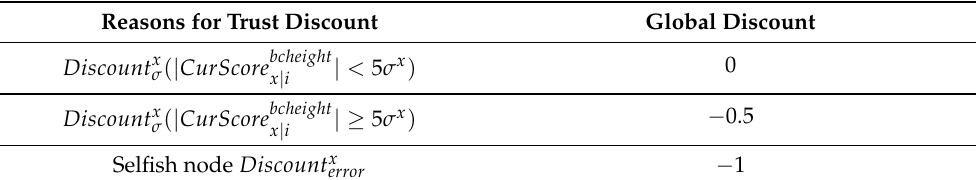
Table 3. The rules for global reputation